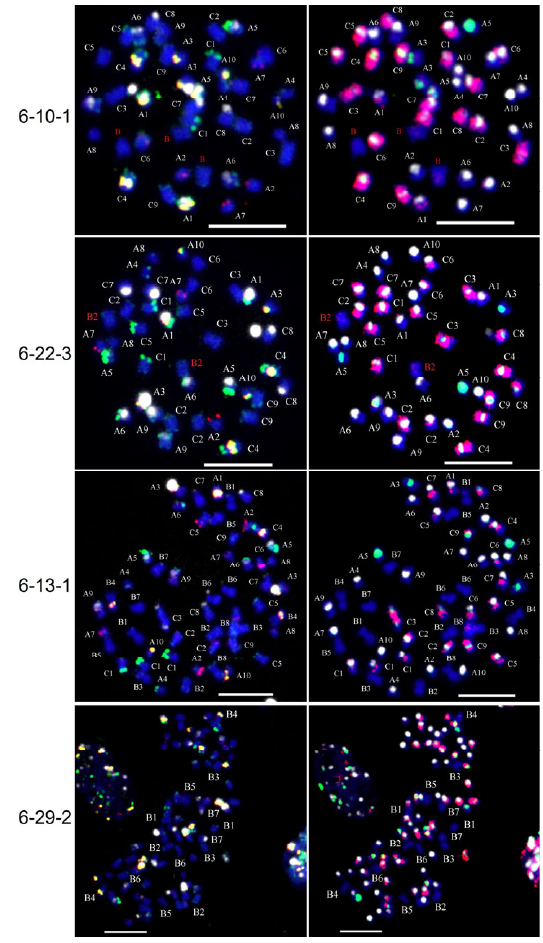
Figure 4. The karyotype analysis in S 2 generation derived from an allohexaploid Brassica hybrid H16 ‐ 1 by multi ‐ color FISH. The signal of 5S rDNA, 26S rDNA, pBrSTR and KBr092N24 showed orange, white, green and red color, respectively. The chromosomes were stained blue by DAPI. All scale bars were 10 µ m.